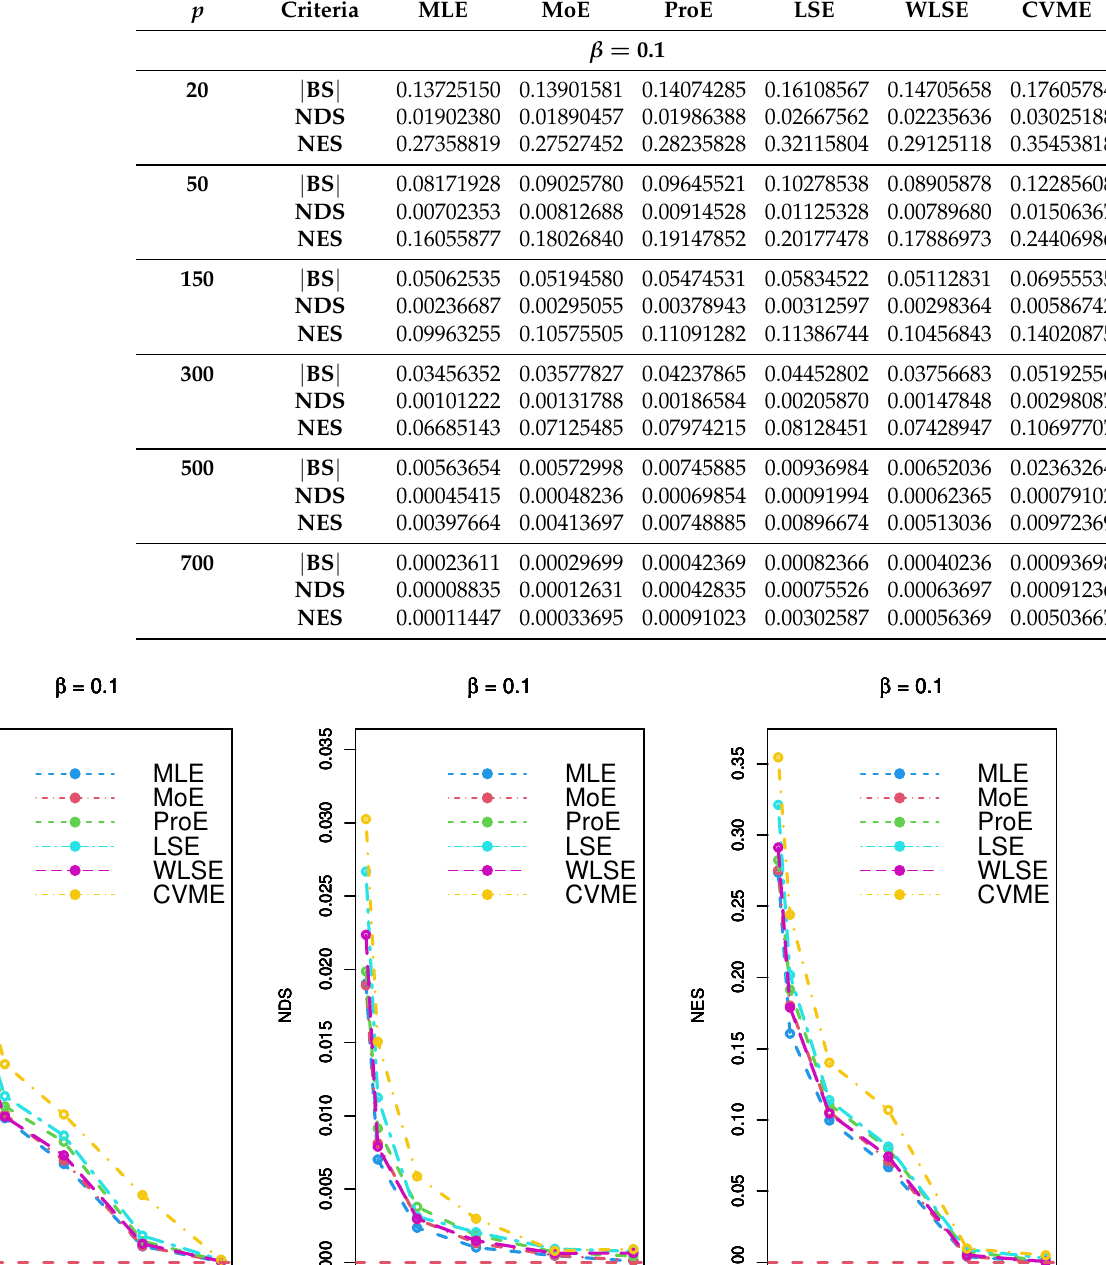
Table 2. The performance of different estimators.